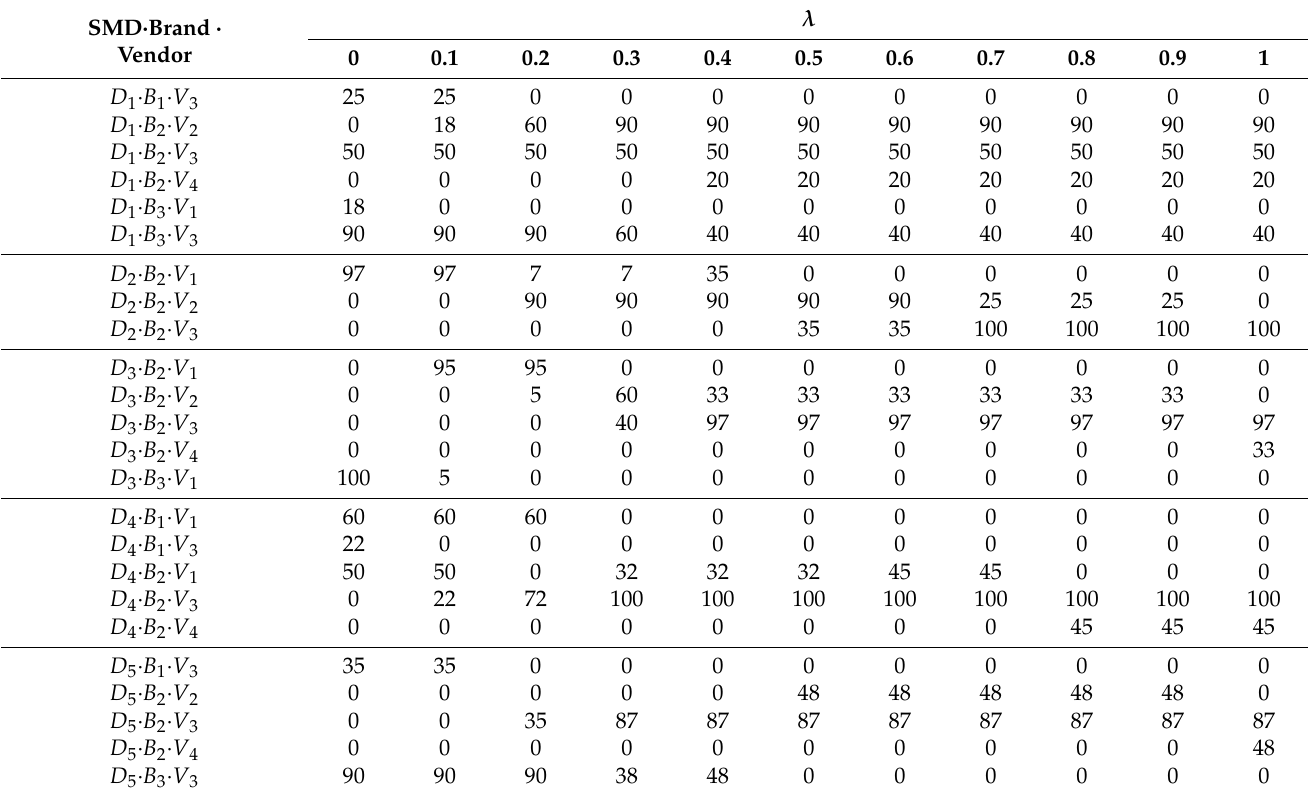
Table 14. The optimal solution for various values of λ